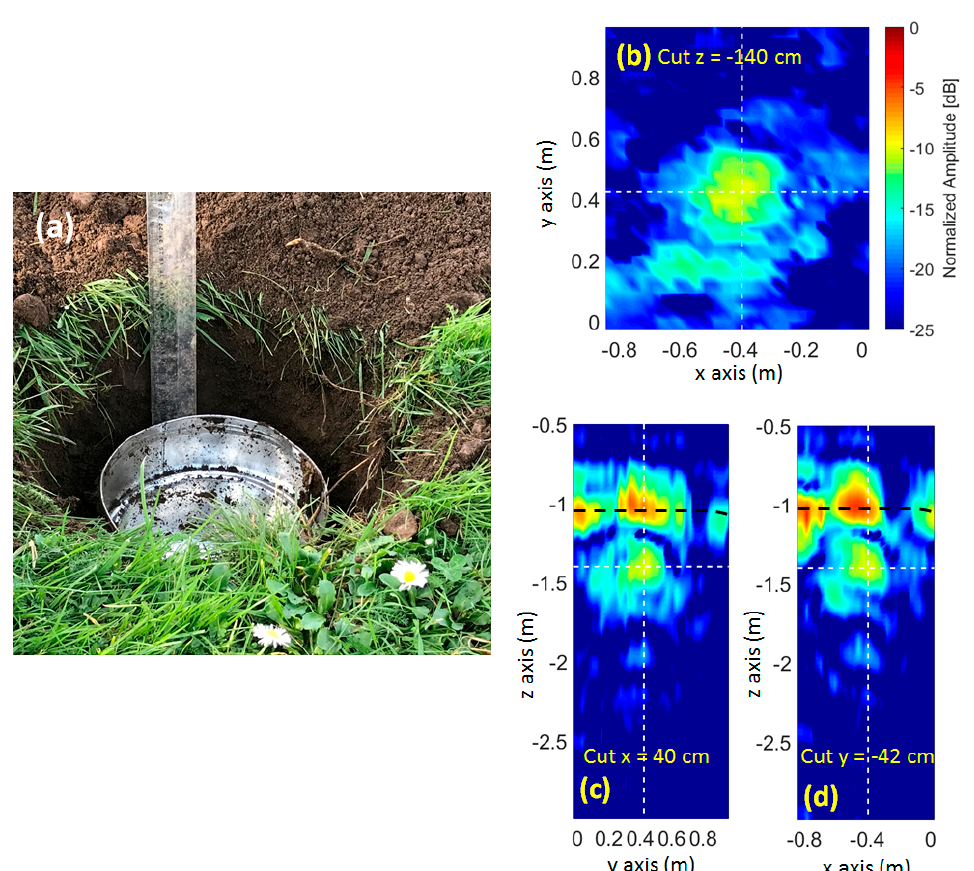
Figure 15. Phase center compensation for the LPA. Picture of the measurement setup with the metallic reference objects ( a ). Reflectivity along z -axis (range) for a position located on top of a flat metallic object ( b ). Sub-bands of 250 MHz ( ∆ R = 60 cm) are considered.